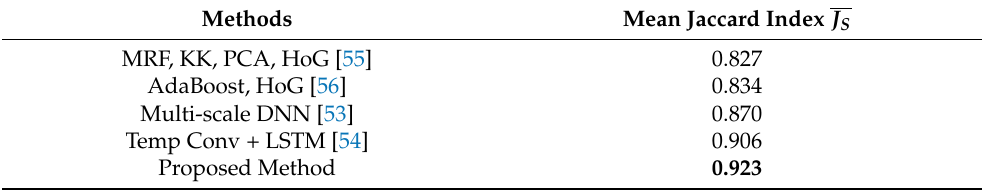
Table 9. Comparison of the proposed method and other methods on Montalbano Gesture